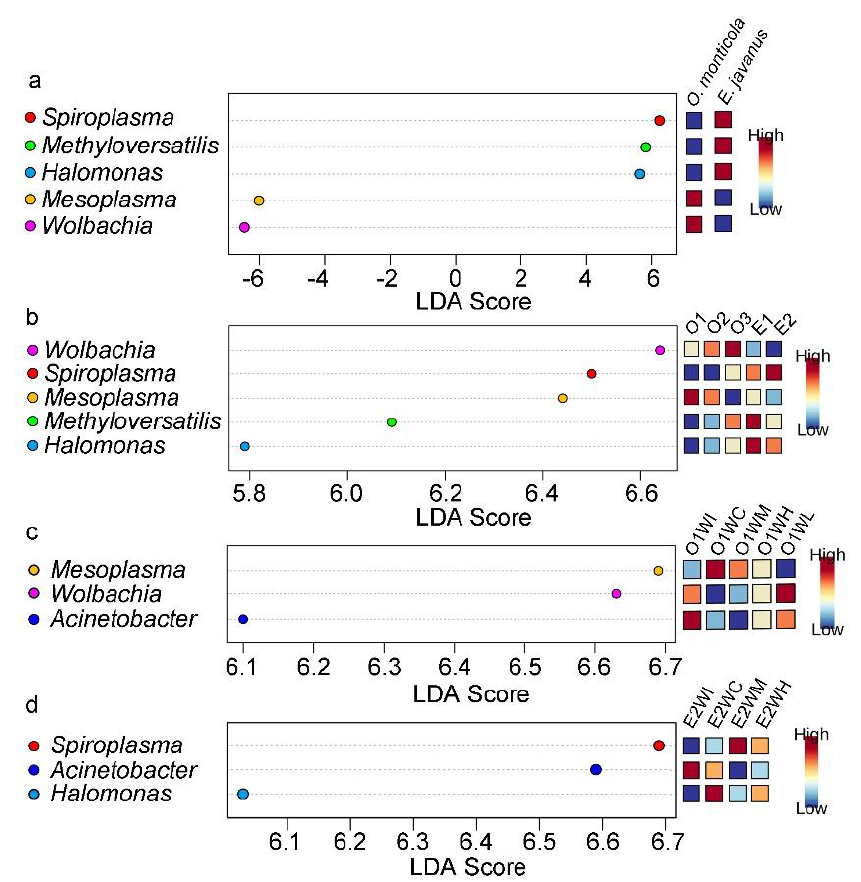
Figure 5. Bacterial genera that significantly differ (FDR adjusted p -value < 0.05) in abundance among different groups. ( a ) Bacterial genera that significantly differ between O. monticola and E. javanus . ( b ) Bacterial genera that significantly differ across three colonies (O1, O2, and O3) of O. monticola and two colonies (E1 and E2) of E. javanus . ( c ) Bacterial genus that significantly differ between samples within colony O1. ( d ) Bacterial genera that significantly differ between samples within colony E2. WI, the infrabuccal pockets of workers; WC, the crop of workers; WM, the midguts of workers; WH, the hindguts of workers; L, larvae. Significant bacterial genera were ranked in decreasing order based on their LDA score ( x axis). The mini heatmap to the right of the plot indicated whether the relative abundance of bacterial genera were higher (red) or lower (blue) in each group.